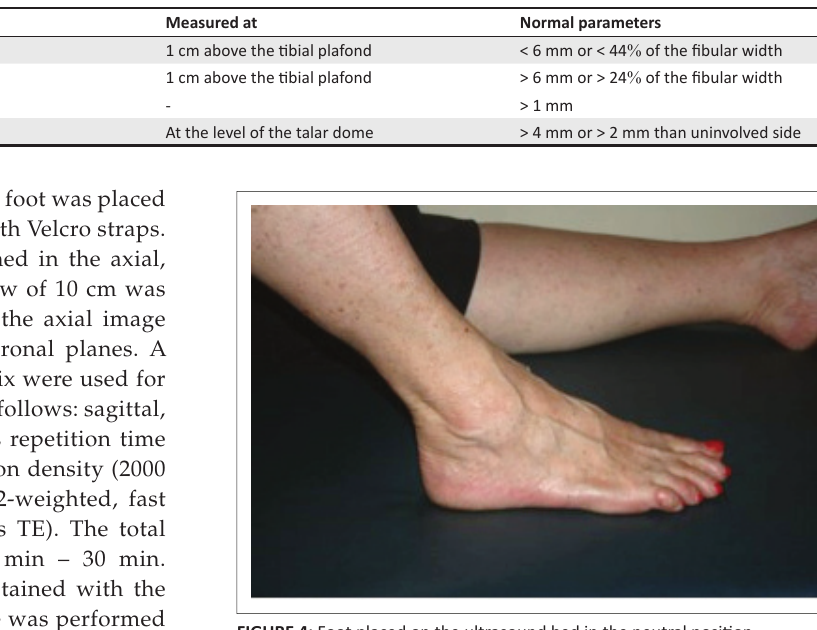
FIGURE 4: Foot placed on the ultrasound bed in the neutral